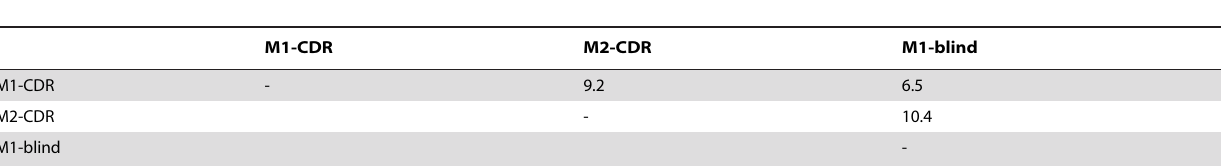
Table 3. RMSD values calculated on the backbone of Ab1-MB2.8 upon best Ab2-AIM2 superposition.